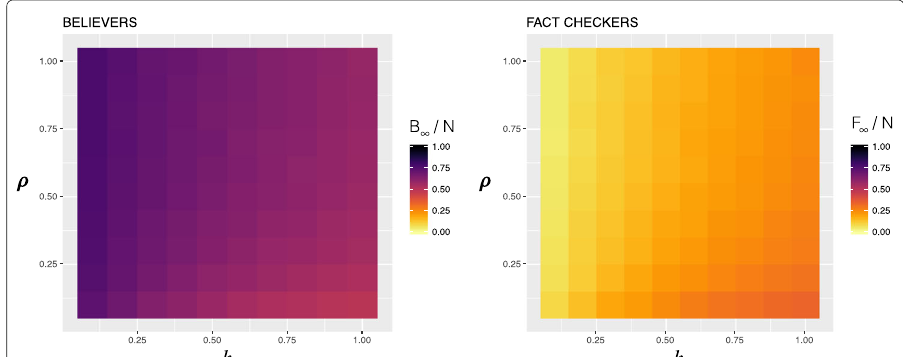
Fig. 6 EternalFC among the skeptic hubs. Phase diagrams that show the densities of Believers and Fact Checkers at equilibrium obtained by simulations of the model in a network of N = 1000 nodes, formed by two communities of 500 agents associated with different values of α : the gullible ( α gu = 0.8) and the skeptic ( α sk = 0.3). The fixed parameters are β = 0.5 and p f = 0.1. Each cell ( h , ρ) corresponds to the averaged value of the relative density over 20 simulations with h ∗ F 0 eternal Fact Checkers (chosen among the highest degree nodes in the skeptic community) and ρ ∗ M rewiring trials, where h , ρ ∈ [0,1]